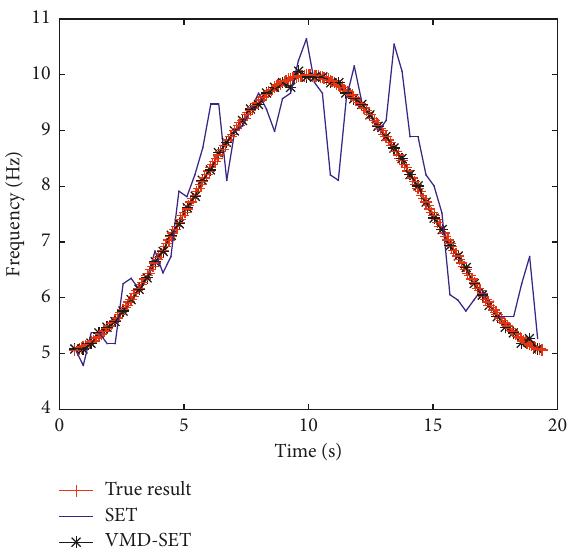
Figure 12: Comparison between estimated instantaneous frequency and true result of SFM